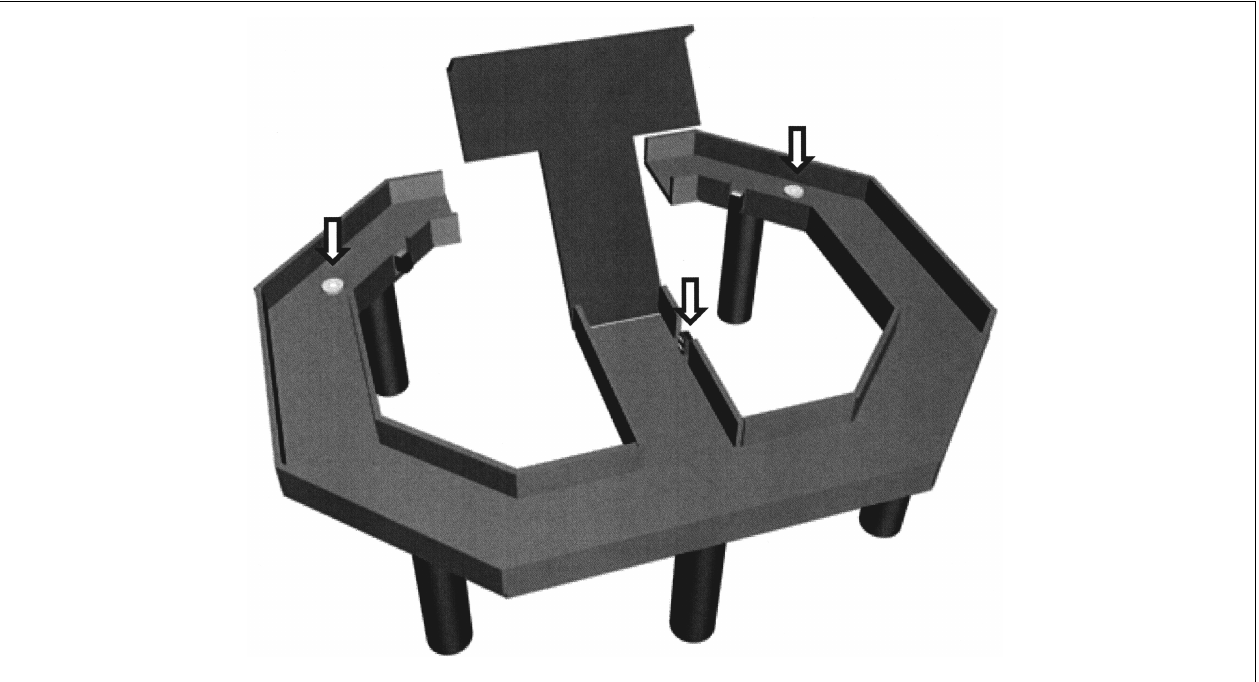
bridge was lowered at the end of the time interval allowing the animal to proceed to either goal location. The central bridge was elevated again when the animal broke a photobeam (arrow) at either goal location. Scale bar: 10